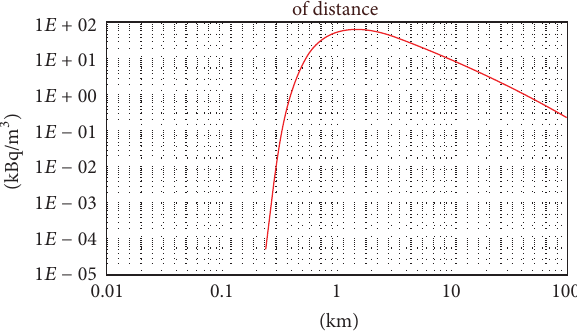
Figure 3: Plume centerline ground deposition of radionuclides as a function of downwind distance in D class.